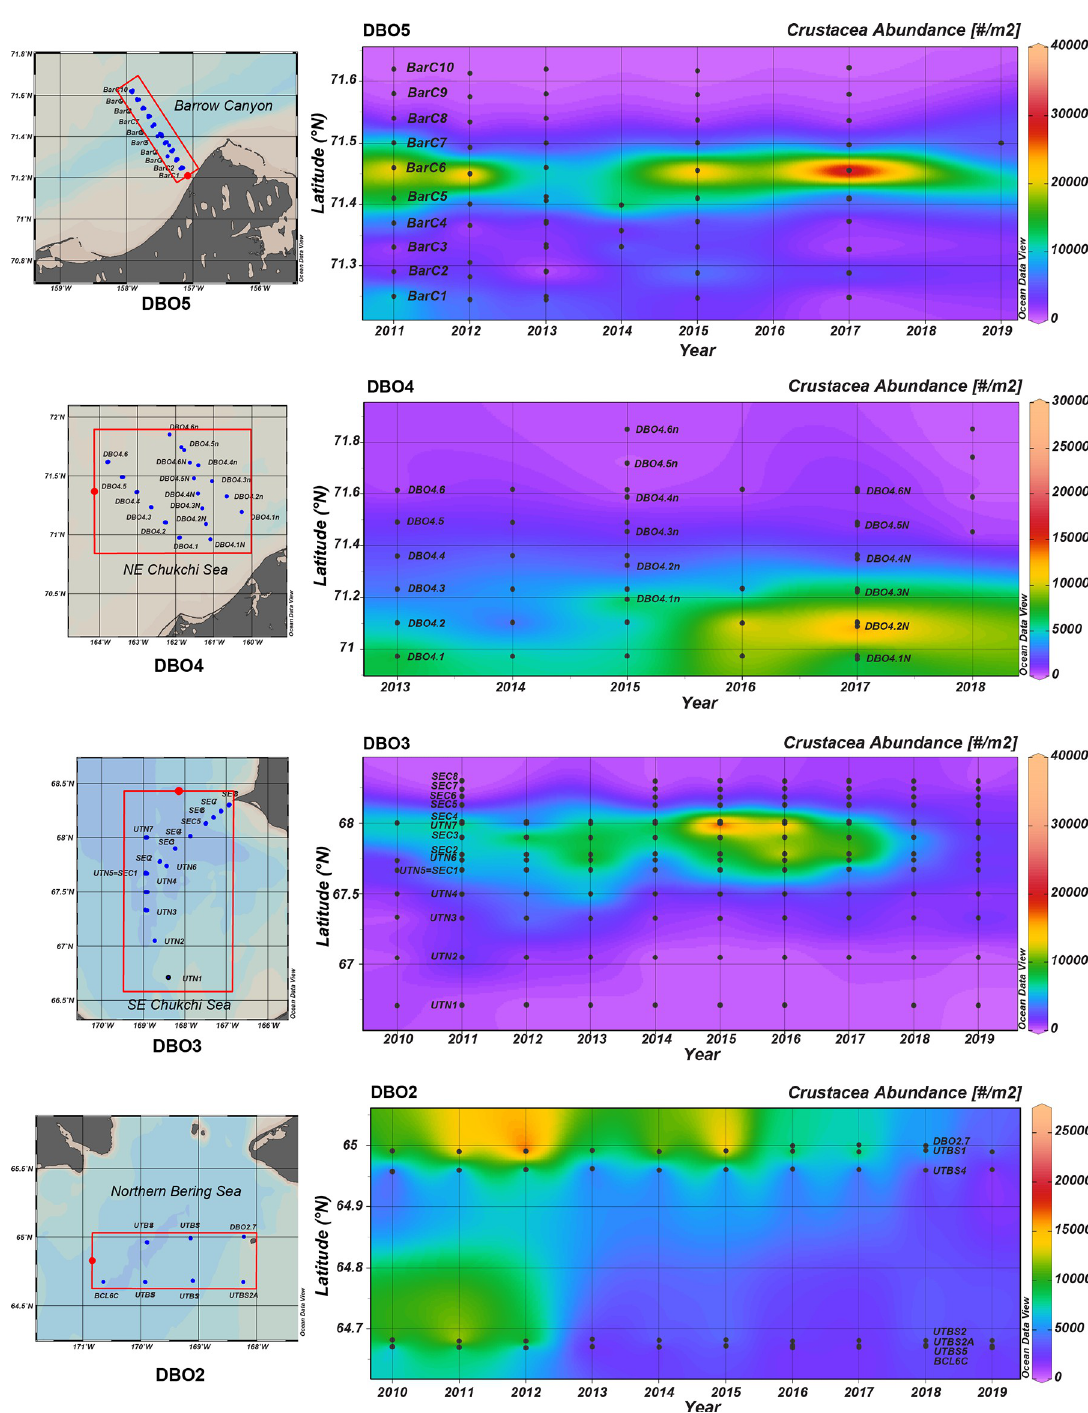
Fig 7. Time series of macrofaunal crustacean abundance at stations in DBO regions 2–5 over the 2010–2019 period. Figures are aligned from south to north over a latitudinal gradient with the red bounding boxes surrounding time series stations in each DBO region. The crustacea summary data plotted in this figure are provided in S3 Table and the Arctic Data Center DBO project page (https://arcticdata.io/catalog/portals/DBO/Data). All crustacean data in each DBO region were plotted using Ocean Data View software under a CC By license; see Methods for details of stations included in the